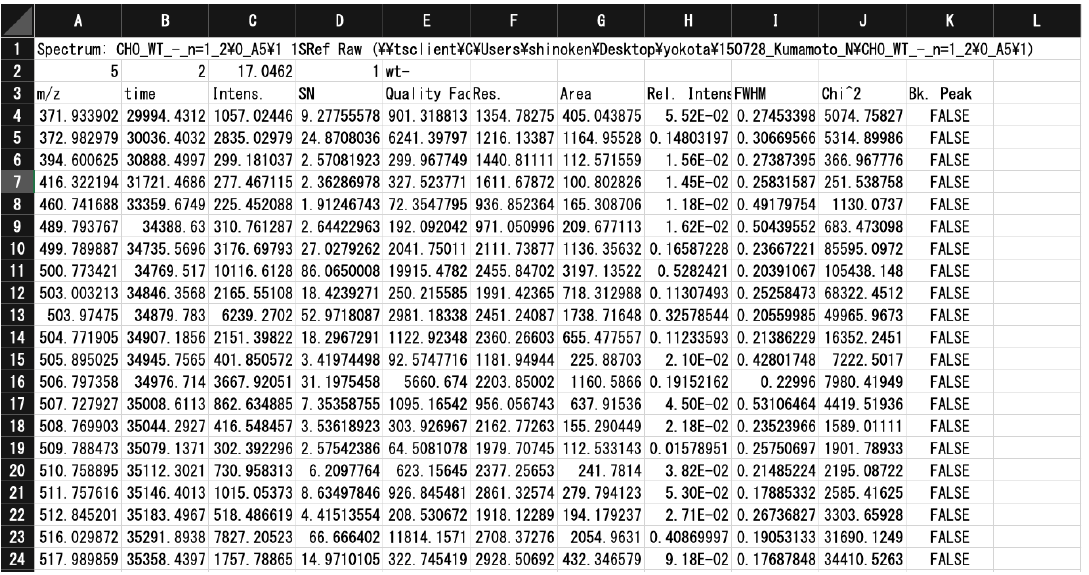
Figure 3. Input file for TAG Expression, a Tab Separated Values file produced by FlexAnalysis